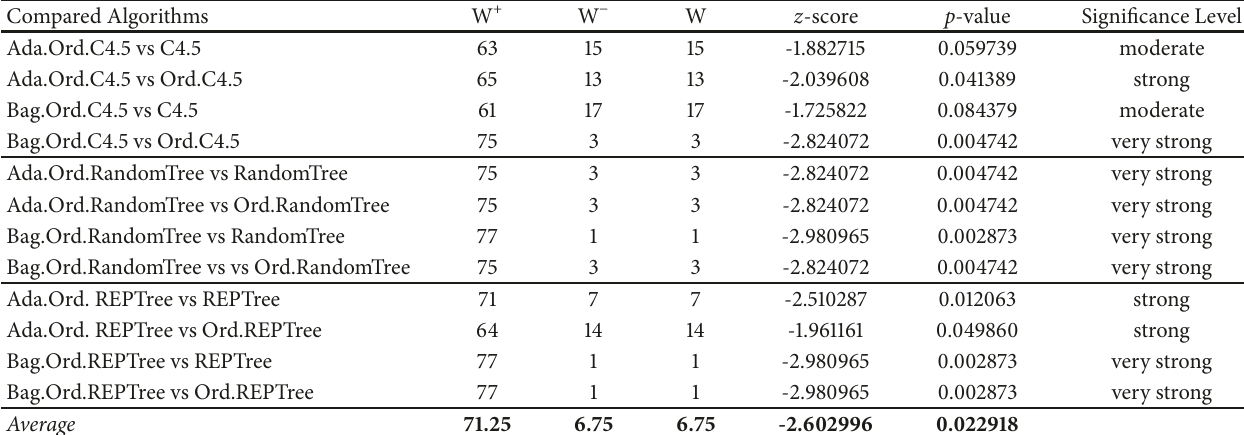
Table 10: Wilcoxon signed ranks test